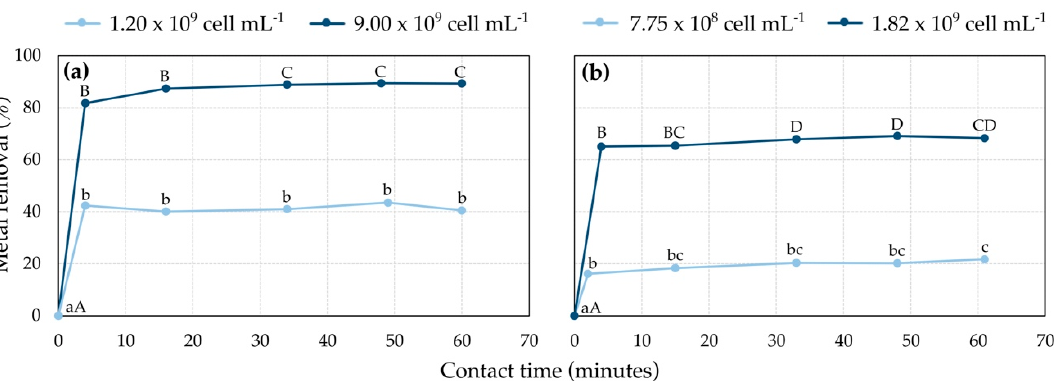
Figure 6. Effect of contact time on biosorption of Ni 2+ (a) onto S. plymuthica strain SC3I(2) and Cu 2+ (b) onto S. plymuthica strain As3-5a(5) biomass (initial Ni 2+ concentration, 50 mg L − 1 ; initial Cu 2+ concentration, 200 mg L − 1 ; temperature, 24 °C; agitation rate, 100 rpm). Letters indicate whether the values differ significantly according to Tukey’s test ( p < 0.05).